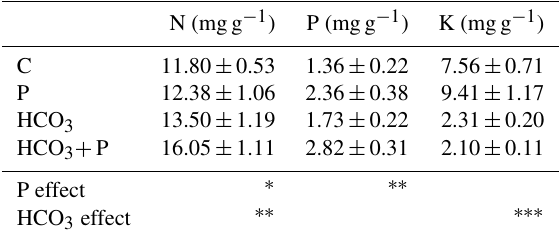
Table 3. Concentrations of N, P and K (mgg − 1 ) in Sphagnum for different treatments. Since no significant differences between species were found, data of both species were combined to dis- play mean ± SE (N = 8). In the effect row, significant differences in P or HCO 3 treatment are indicated by asterisks: ∗ P ≤ 0 . 05, ∗∗ P ≤ 0 . 01 and ∗∗∗ P ≤ 0 . 001.